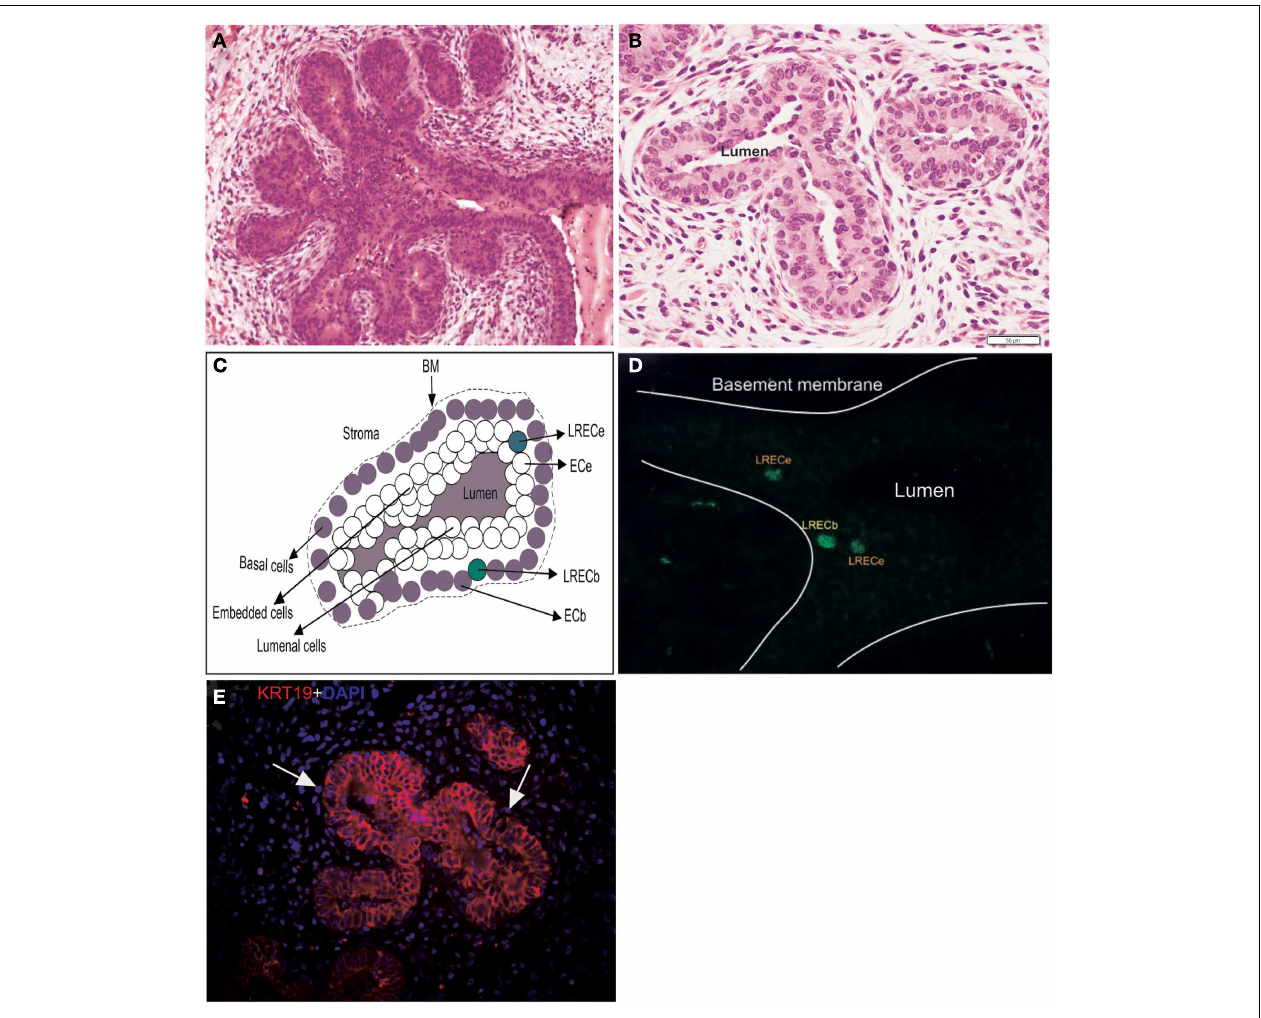
cells dissected. BM, basement membrane. (D) Micrograph of cryosections stained for BrdU antigen prior to laser microdissection, localization of LRECb and LRECe are depicted. (E) Micrograph of epithelium of terminal ductular unit stained for KRT19.The basal layer consists of cells that are predominantly